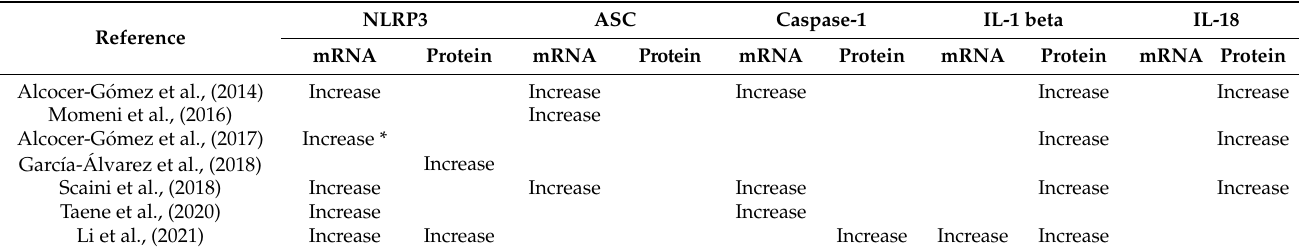
Table 2. Protein and Gene Expression Levels of the NLRP3 Inflammasome in Mood Disorder Studies. No studies measured ASC protein levels. * Denotes one study which demonstrated decreased levels of the NLRP3 inflammasome specifically in MDD patients taking medication